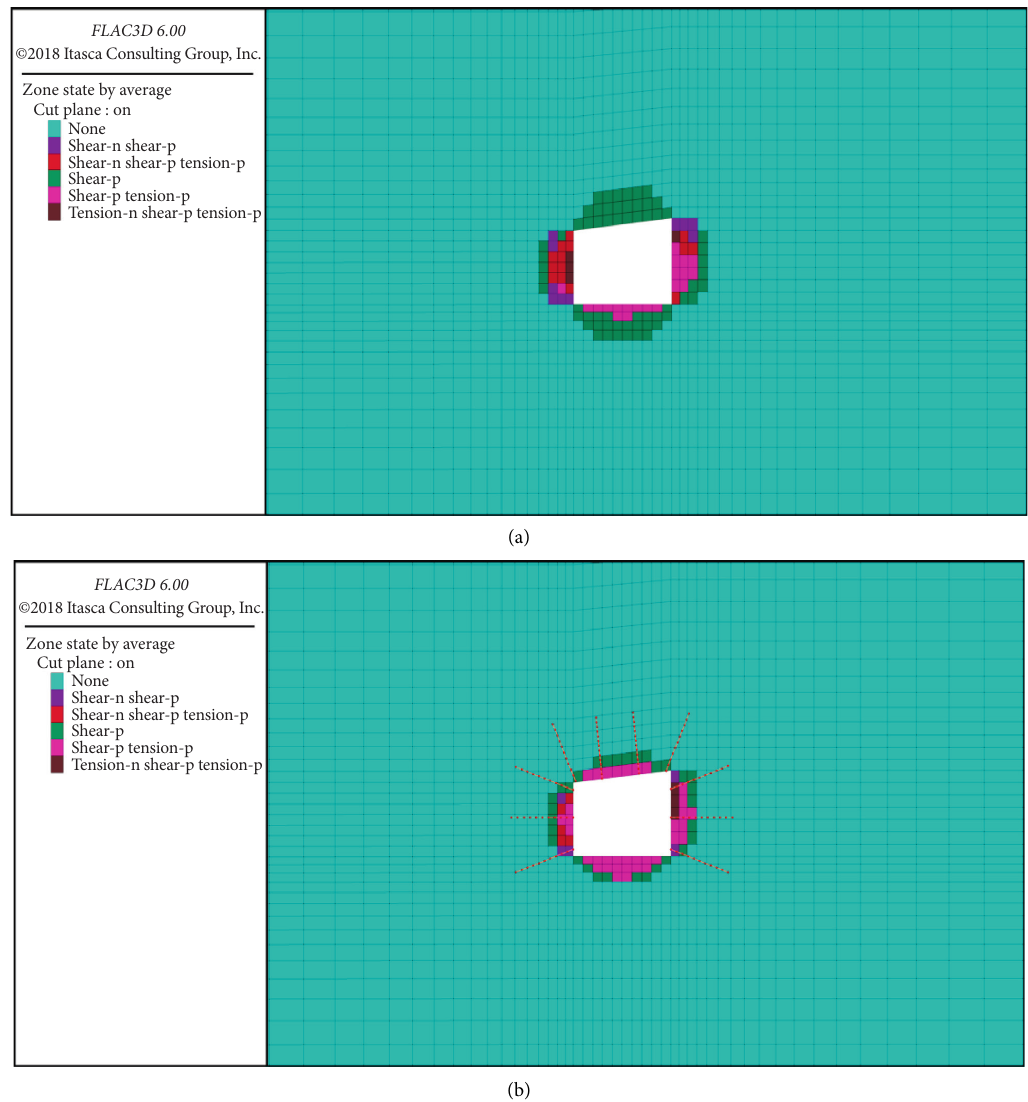
Figure 9: Distribution law of surrounding rock elastoplastic zone of the roadway with different support conditions: (a) original support and (b) reinforced